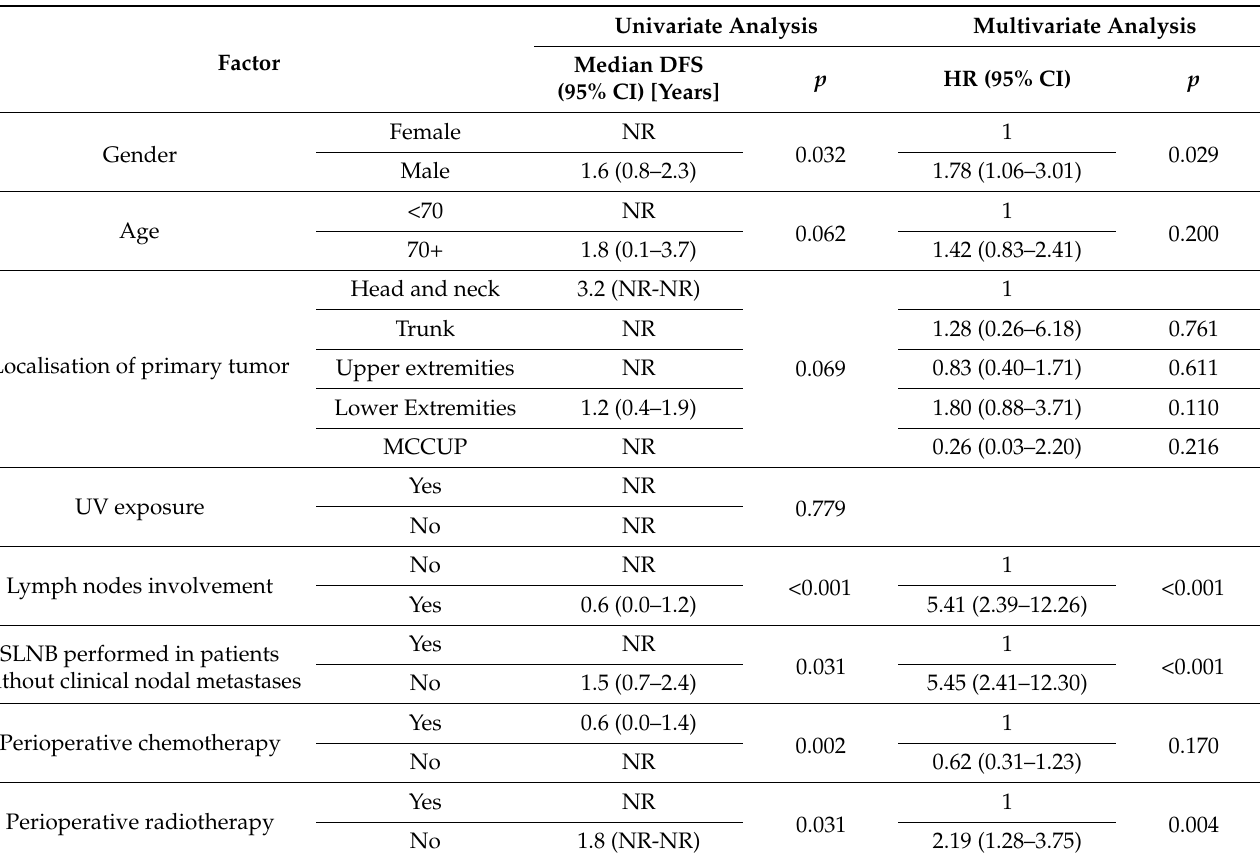
Figure 3. Overall survival in the study population. Table 2. Univariate and multivariate analysis of factors associated with disease-free